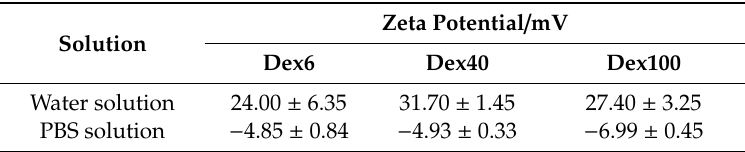
Table 1. Zeta potential of tested polymers depending on the used